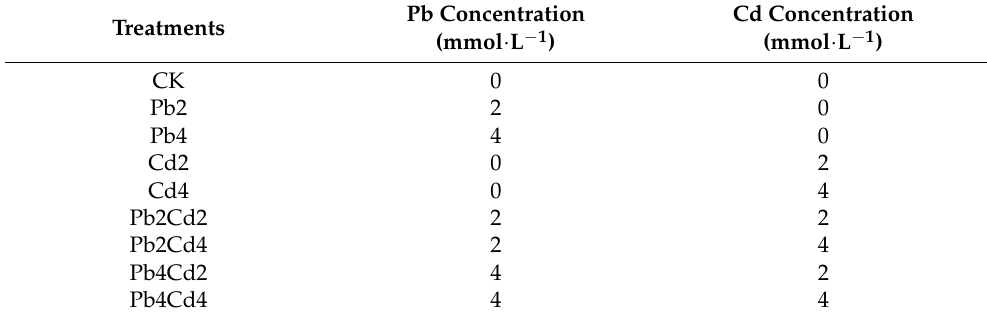
Table 2. Experimental